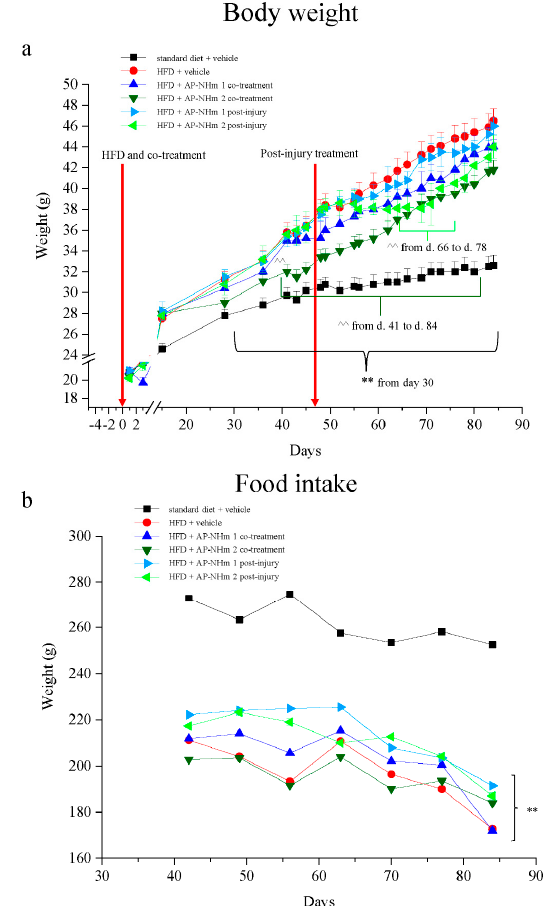
Figure 5. Effects of high-fat diet (HFD) and AP-NHm 1–2, in co-treatment or in post-injury treatment, ( a ) on body weight from Day 0 and ( b ) on food intake from Day 42 to Day 84. Mice were fed with normal or HFD diet from Day 0 to Day 84: two groups were co-treated with AP-NHm while other two groups started AP-NHm treatment on Day 49. Control groups were treated with vehicle throughout the study. Each value represents the mean ± SEM of 12 mice per group. ** p < 0.01 vs. standard diet + vehicle, ^^ p < 0.01 vs. HFD + vehicle. 3.2.2. AP-NHm has Hypocholesterolemic, Hypolipidemic and Hypoglycemic Effects Blood levels of total cholesterol, triglycerides and glucose were measured every week to monitor the typical metabolic alterations of this disease model that, starting from Day 42, showed a significant increase in comparison to normal diet-fed group, thus leading to set the beginning of the post-injury treatment on Day 49, i.e., when hepatosteatosis syndrome was firmly settled. In Table 4 the effects of both AP-NHm mixtures in the co-treatment and post-injury protocols (in table marked as groups 3–